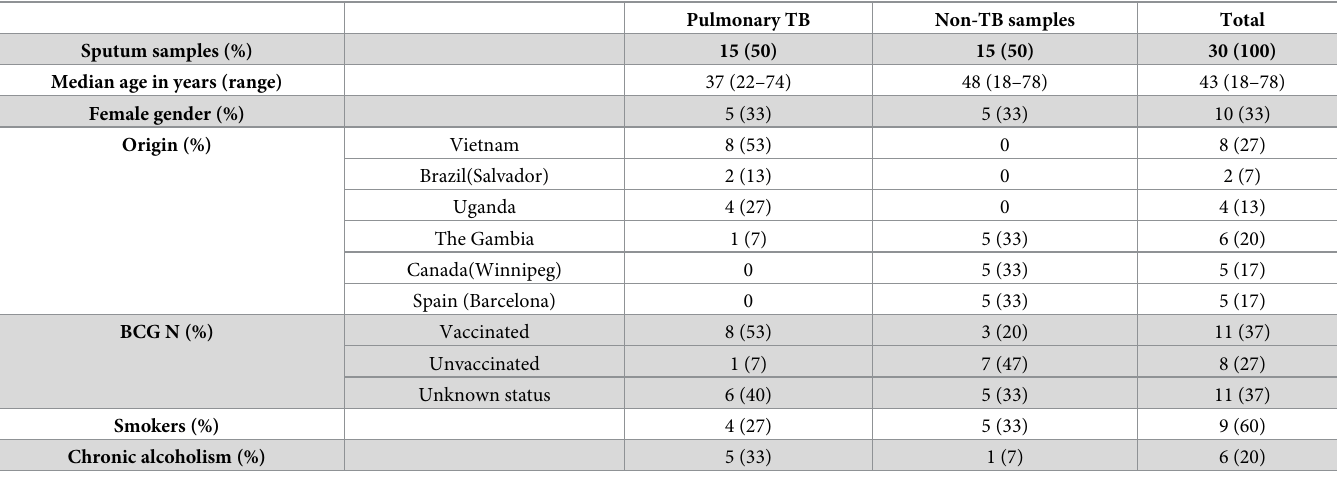
Table 1. Characteristics of the first batch of samples received from